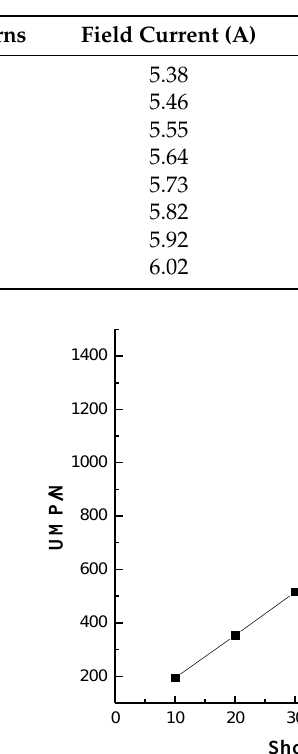
Table 6. The RMS of the harmonic current of stator and rotor when field concentric coil undergoes different short circuit turns.